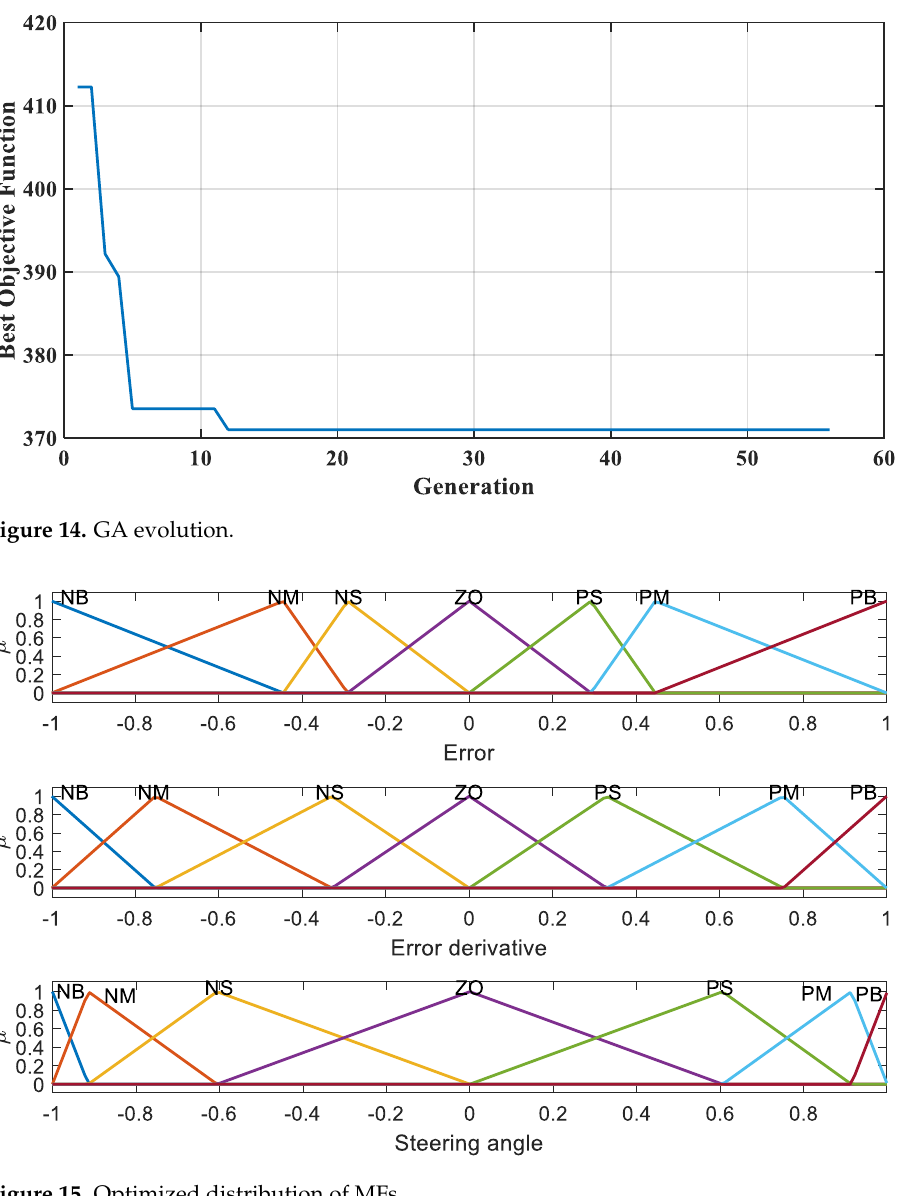
Figure 15. Optimized distribution of MFs.